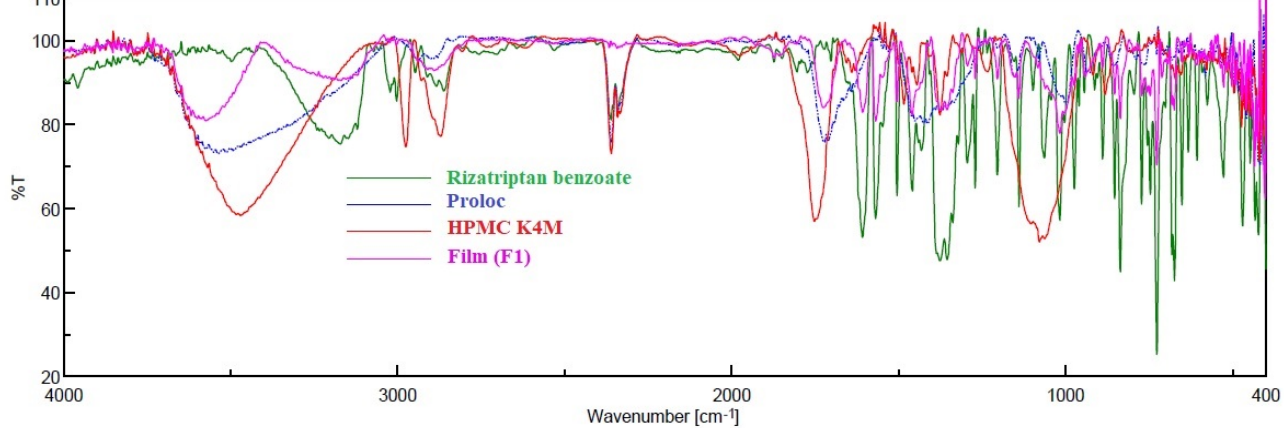
Figure 2. FTIR spectra of rizatriptan, Proloc, HPMC F4M and drug-loaded buccal film (F1).